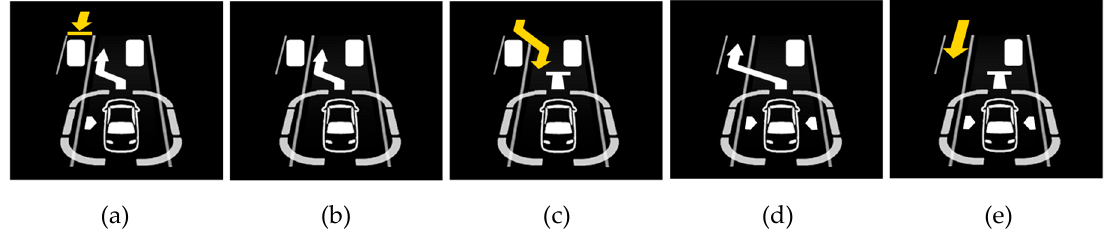
Figure 8. Visualization of the maneuver in the IC during the bottleneck scenarios: ( a ) bottleneck narrowed on both sides, AV insists on the right of way; ( b ) bottleneck narrowed on both sides, no oncoming traffic, AV passes; ( c ) bottleneck narrowed on both sides, AV yields the right of way; ( d ) bottleneck narrowed on one side, no upcoming traffic, AV passes; ( e ) bottleneck narrowed on one side, AV yields the right of way.